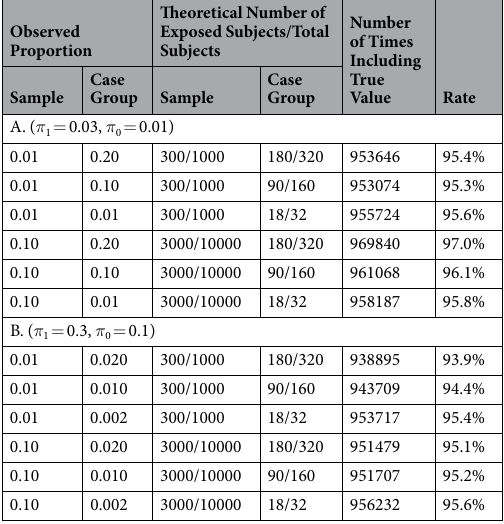
Table 3. Number of times the true value (relative risk: 3.0) was included in 95% confidence interval in each one million trials. For a population of 100000, in which 30000 people was exposed, two sets of risk (A and B) were applied. In A, risk of exposed subjects ( π 1 ) is 0.03 and that of unexposed subjects ( π 0 ) is 0.03; the number of exposed and unexposed subjects for whom an event occurred is 900 and 700. In B, π 1 = 0.3 and π 0 = 0.1; 9000 exposed subjects and 7000 unexposed subjects developed an event. Sample, exposed case group, and unexposed case group were picked one million times for each of six sets of observed proportions from the corresponding subjects, and confidence limits were computed each time.